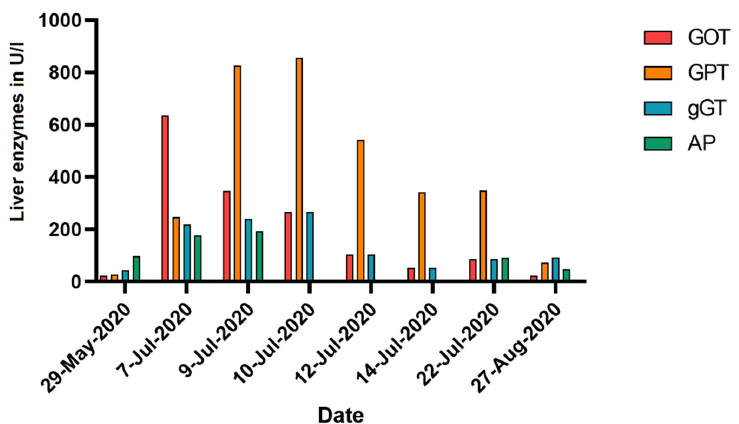
Figure 3. Laboratory results in the course of immune-related hepatitis of patient #1, which has been diagnosed in July 2020 and resolved in the course of the same month upon treatment with methylprednisolone 2 mg/kg body weight. Abbreviations: GOT = aspartate aminotransferase (AST); GPT = alanine aminotransferase (ALT); gGT = gamma-glutamyl-transferase; AP = alkaline phospha- tase.